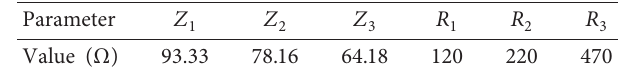
Table 3: Power combiner